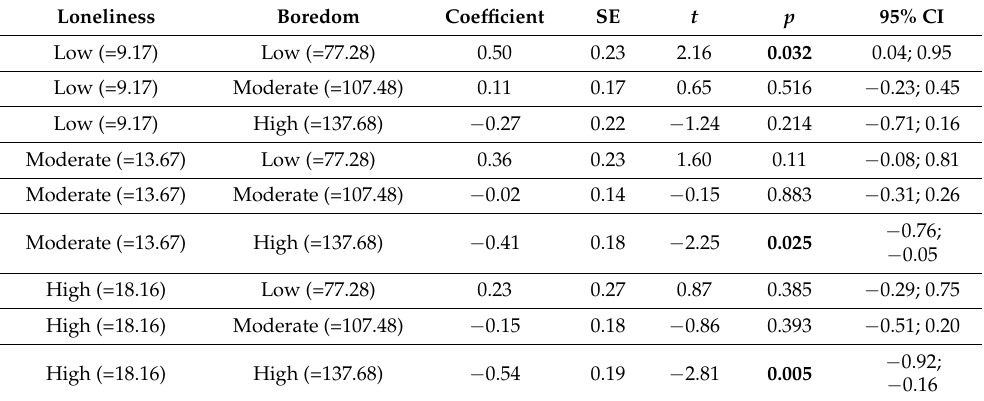
Table 6. Conditional Effect of Focal Predictor (Extraversion) at Values of the Moderator Variables (Loneliness and